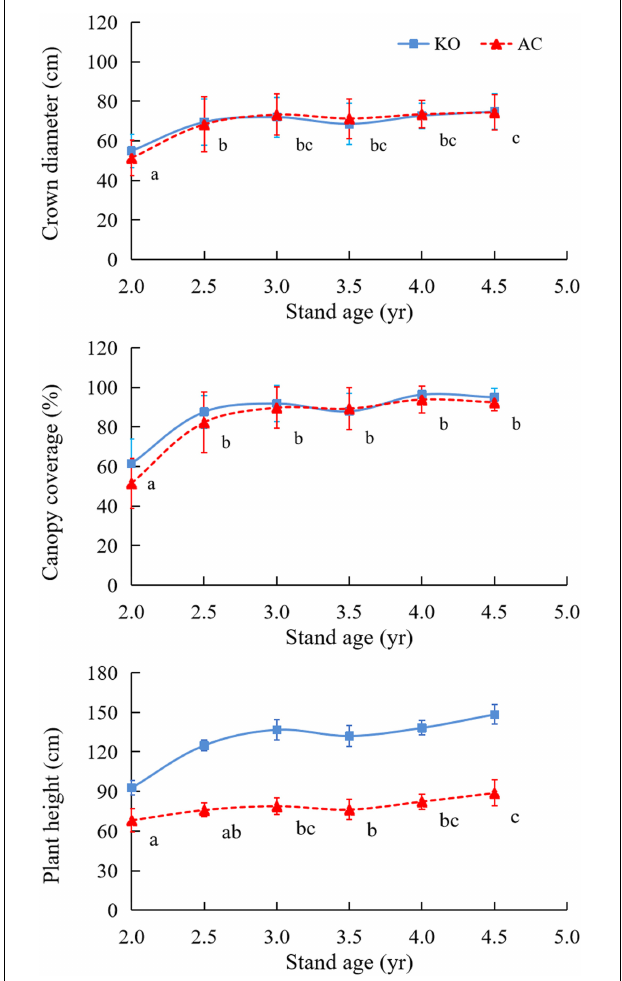
FIGURE 1 | Crown diameters, canopy coverages, and plant heights of the two mangrove sites. Different letters indicate significant differences among the stand ages at p <